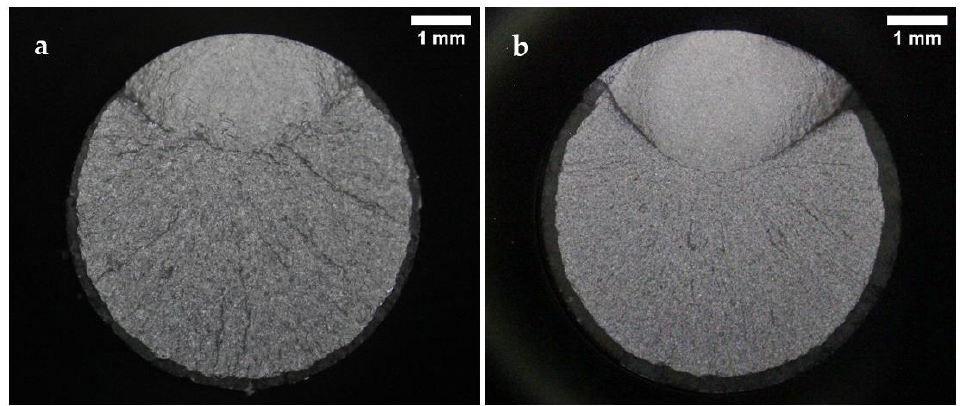
Figure 7. Fracture surfaces after fatigue tests of ( a ) A-type and ( b ) B-type H13 steels, tested in air to a maximum stress of 1160 MPa (81% and 78% YS, respectively).